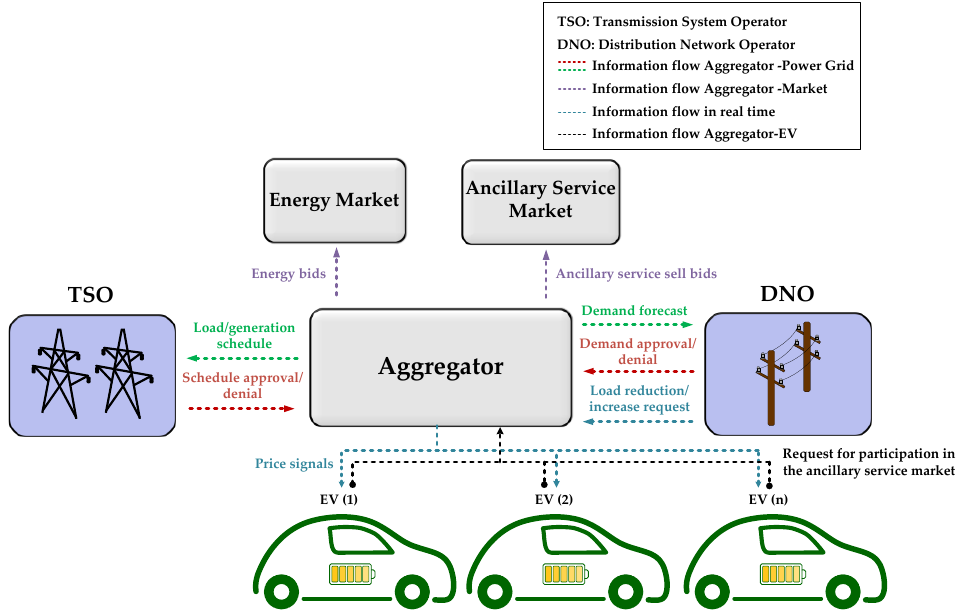
Figure 9 . Decentralized control architecture of EV charging [15]. Figure 9. Decentralized control architecture of EV charging